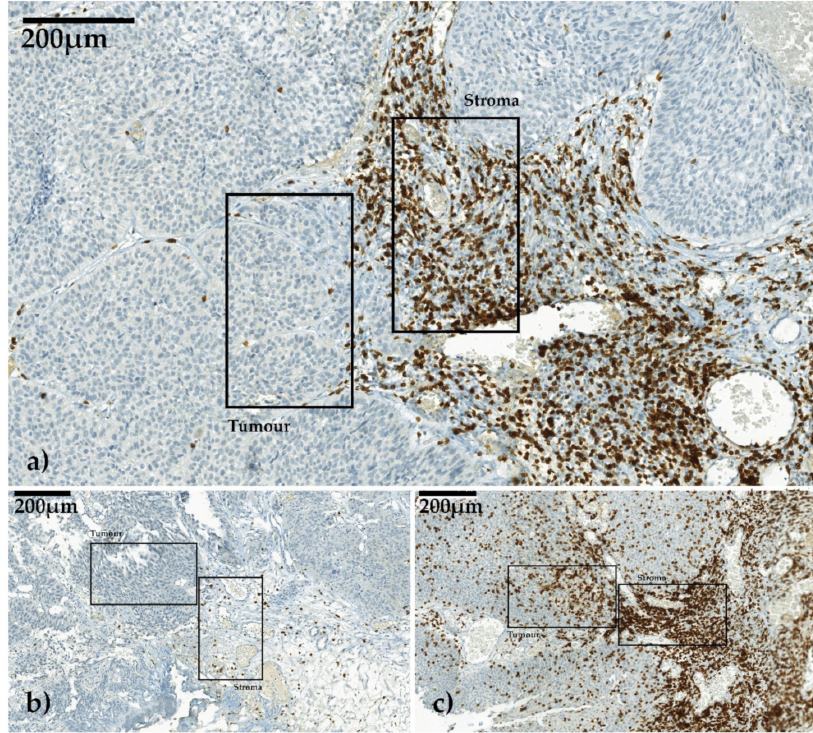
Figure 4. Three di ff erent CD3-stained slides in non-muscle-invasive bladder cancer (NMIBC) viewed in Panoramic Viewer 1.15.4. Selection of one high-power field (HPF) each for stroma and for tumor infiltration. Invasion front was between these two corresponding HPFs. The images were scanned with digital slide scanner (camera: CIS VCC, Panoramic MIDI Scan; 3DHistech Ltd., Budapest, Hungary). ( a ) Example for moderate stroma infiltration and low tumor infiltration, ( b ) example for low stroma infiltration and low tumor infiltration, ( c ) example for high stroma infiltration and high tumor infiltration.